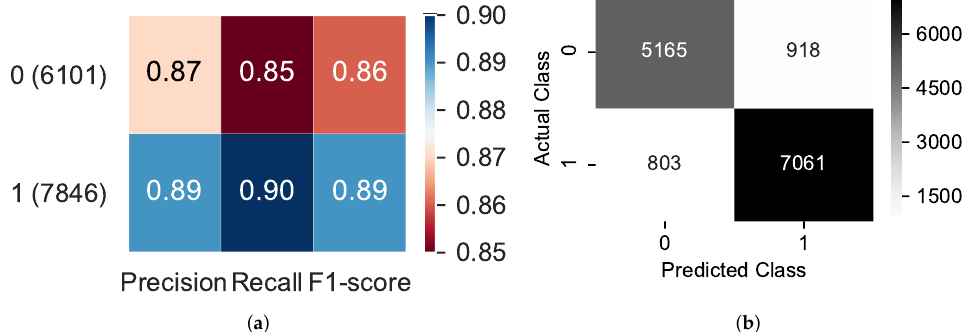
Figure 5. The three measures (i.e., precision, recall, and F1-score) and the confusion matrix used to evaluate our proposed method. ( a ) The evaluation metrics used to evaluate our method. ( b ) The confusion matrix for the two